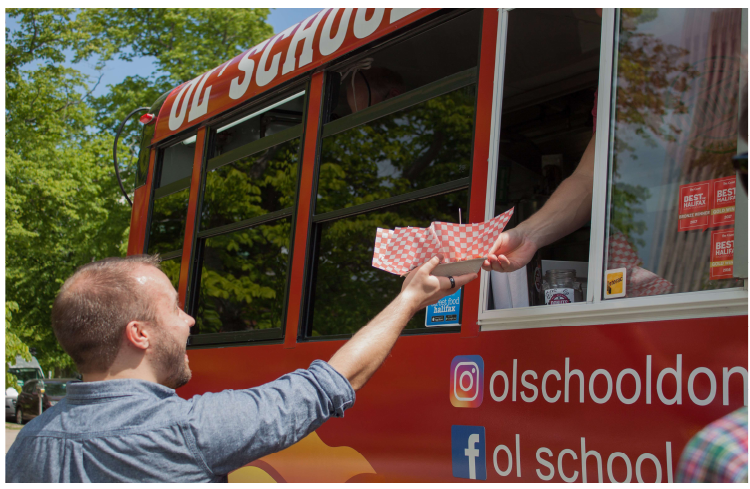
Figure 1. Who doesn’t love doughnuts? CSV2018 volunteer Lucas Jarche (who designed the CSV logo) demonstrates proper form in receiving a piping-hot order of fresh